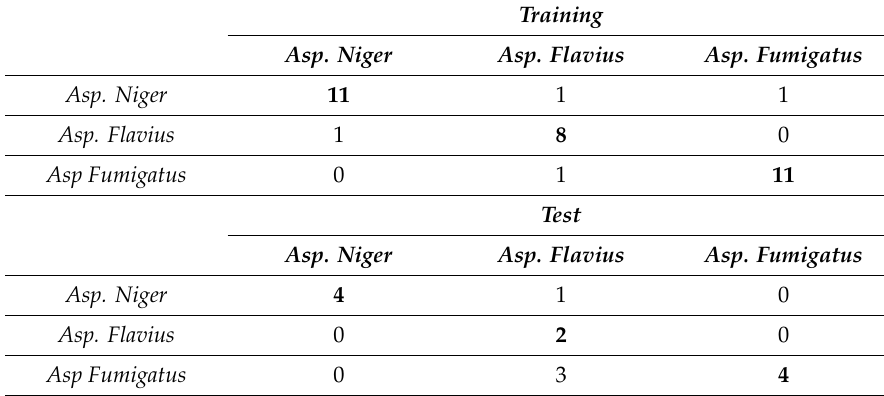
Table 1. Confusion matrix of the LDA model in training and test. Correct identifications are emphasized with bold